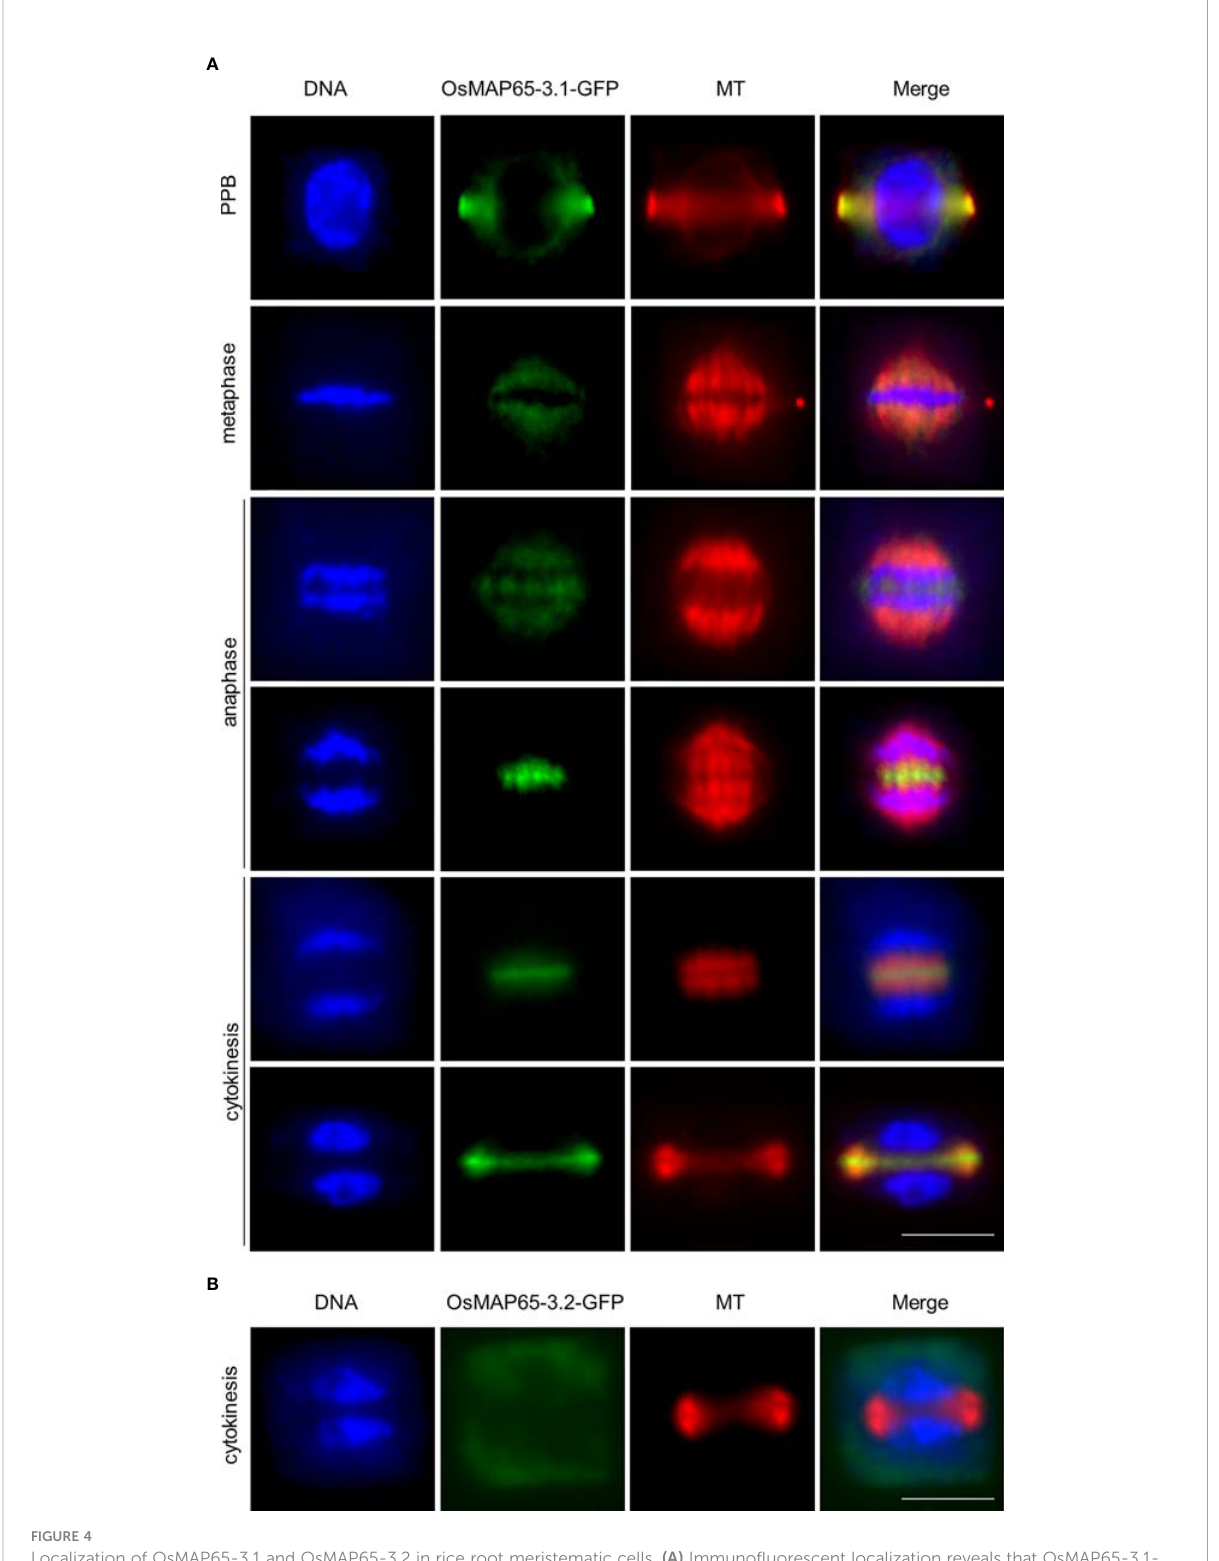
FIGURE 4 Localization of OsMAP65-3.1 and OsMAP65-3.2 in rice root meristematic cells. (A) Immuno fl uorescent localization reveals that OsMAP65-3.1- GFP binds to MTs (PPB, spindles and phragmoplast) in all mitotic phases including prophase, metaphase, anaphase, telophase and cytokinesis. (B) No OsMAP65-3.2-GFP signal is observed at phragmoplast MTs in cytokinesis. Bar = 10 um (A, B)